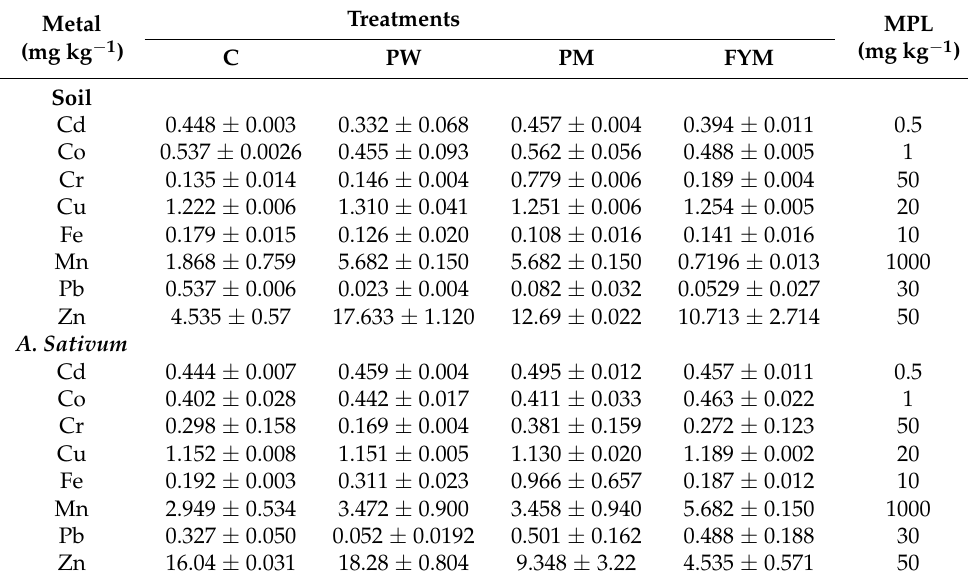
Table 1. Heavy metal concentrations in soil and Allium Sativum L. (mg kg − 1 ).